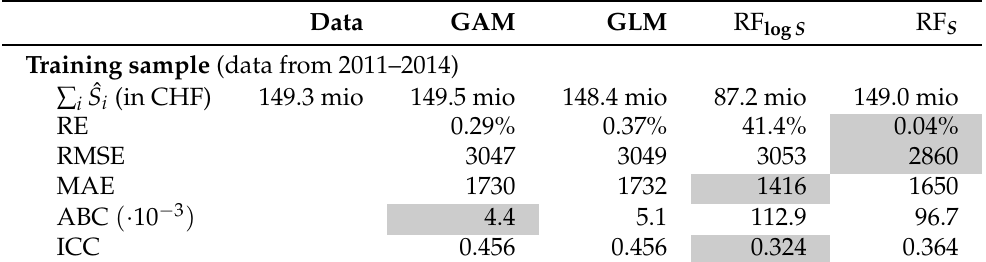
Table 3. Comparison of the total predicted severity ∑ i ˆ S i , goodness-of-fit statistics (GOF) and goodness-of-lift statistics (GOL) across the generalized additive models (GAM), generalized linear models (GLM), and random forests (RF) models in the training